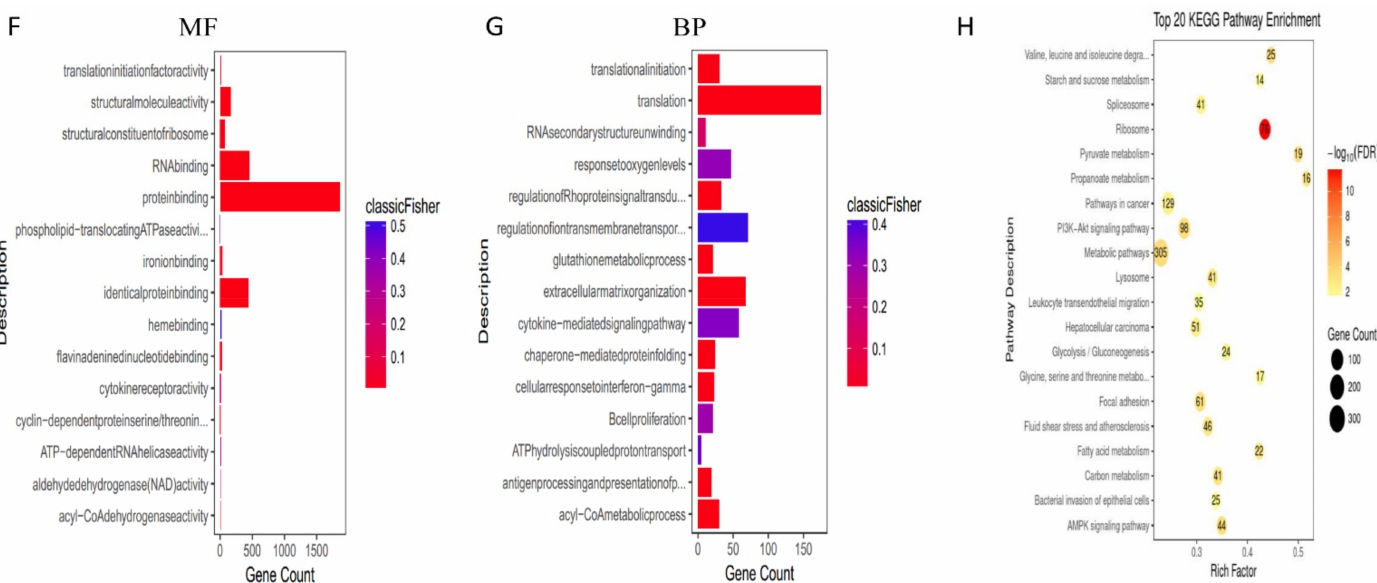
Figure 5. The analysis of mRNA-seq data from neBAT and aBAT. ( A ) Heat map showing expression profiles of mRNA. ( B ) Volcano map of mRNA. The volcano plot shows significance on the y-axis ( − log10, p -value) against the gene expression ratio (log2, fold change of neBAT versus aBAT), and the FDR cuto ff < 0.05 is indicated. ( C ) Number of upregulated and downregulated genes in neBAT and aBAT. ( D ) Venn diagrams of neBAT versus aBAT. ( E – G ) GO categories for DEGs. ( H ) KEGG analysis of DEGs. Count number and p -value of DEGs in